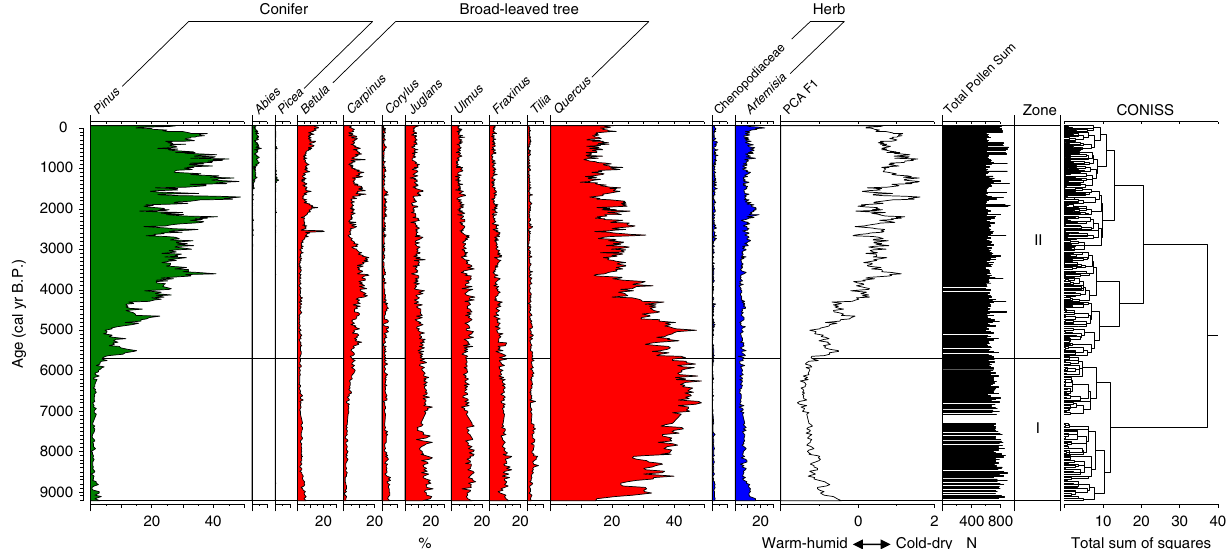
Fig. 2 Pollen diagram of major pollen types and PCA F1 sample scores for Lake Xiaolongwan. The green, red, and blue silhouettes represent conifers, deciduous broad-leaved trees, and herbs, respectively. Positive PCA F1 sample scores represent cold-dry climatic conditions, whereas negative PCA F1 sample scores represent warm-humid